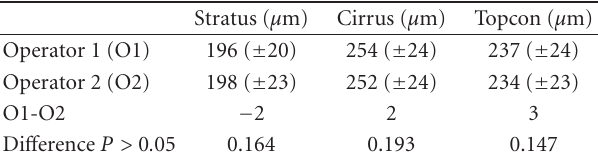
Table 3: Comparison of central macular thickness obtained by each operator and each OCT